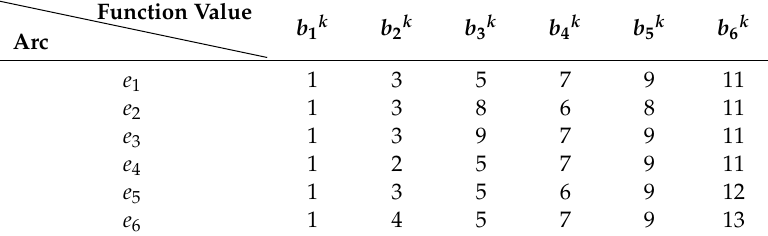
Table 2. Fuzzy function of flow and time for each arc.